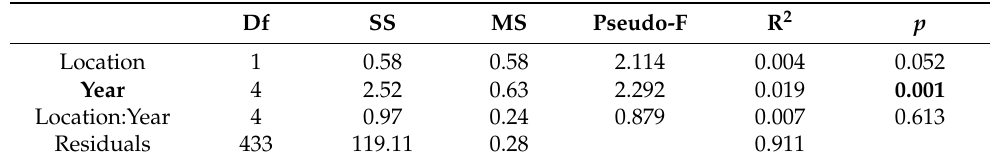
Table 1. PERMANOVA results for trophic level matrix across year and location. Bold numbers indicate significance. Df = degrees of freedom, SS = sum of squares, MS = mean squares. Significant values in bold.